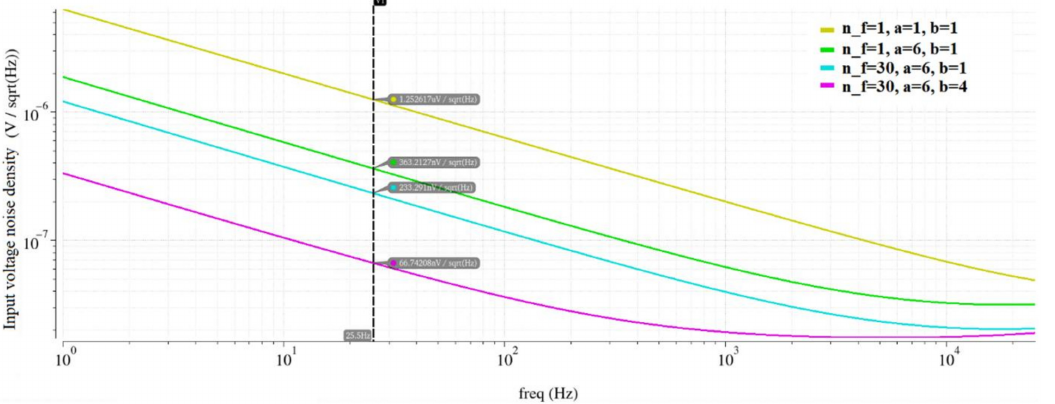
Figure 10. Noise optimization steps.